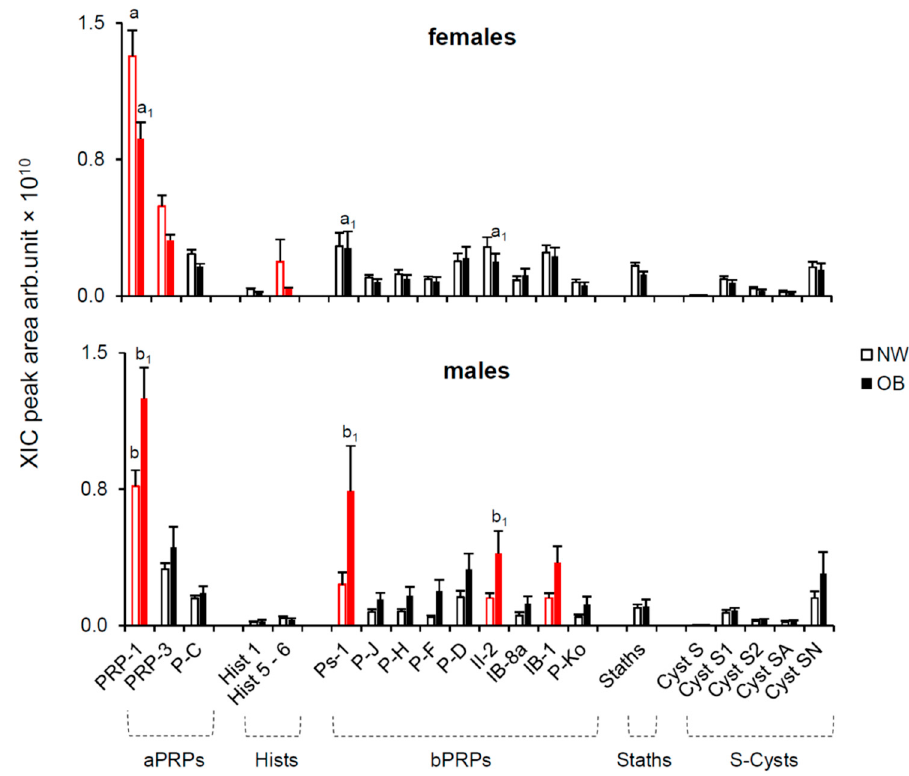
Figure 3. Mean values ( ± SEM) of the XIC peak areas of the PRP-1, PRP-3, P-C, Hist 1, Hist 5-6, Ps-1, P-J, P-H, P-F, P-D, II-2, IB-8a, IB-1, P-Ko, Staths, Cyst S, Cyst S1, Cyst S2, Cyst SA and Cyst SN in unstimulated saliva of NW and OB according to gender. Males: NW n = 21, OB n = 23; females: NW n = 34, OB n = 40. Red color indicates a significant difference between NW and OB ( p ≤ 0.013; Fisher’s test LSD). a 1 , b 1 = significant difference between females and males with obesity; a, b = significant difference between NW females and males ( p ≤ 0.013; Fisher’s test LSD).